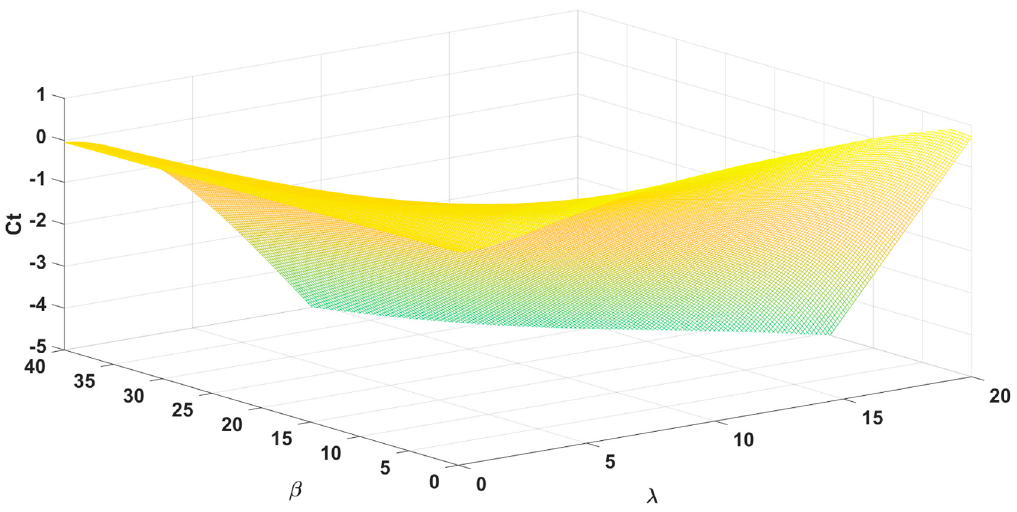
Figure 4. The thrust coefficient for 5-MW VSWT.